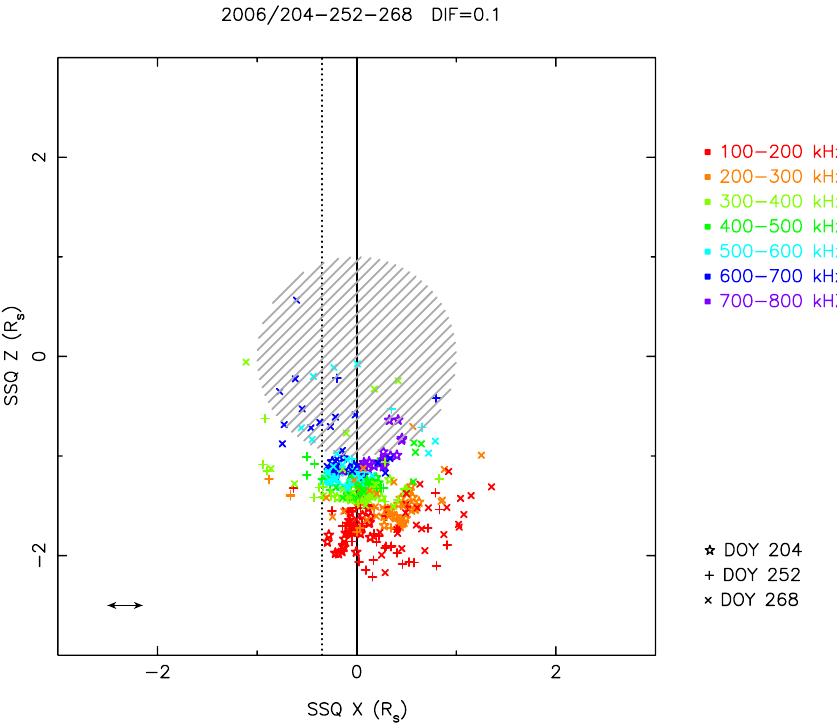
Fig. 4a. Results of direction finding in the SSQ x-z plane for time periods during 3 passes for which all four constraints above were satisfied. These include days 204, 252, and 268 of 2006. The time intervals that satisfied the criteria are listed as well as the actual time of direction finding and the frequency range. The symbol code corresponds to different days, and the color code defines the frequency range.